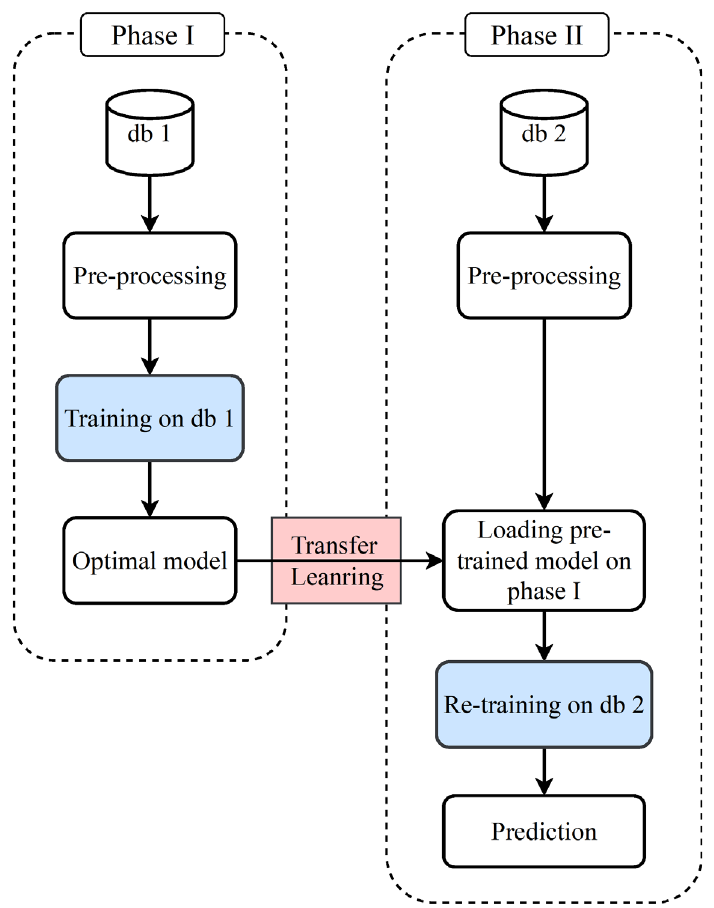
Figure 1. The presented framework of a-day-ahead PV power prediction using transfer learning and deep neural network.